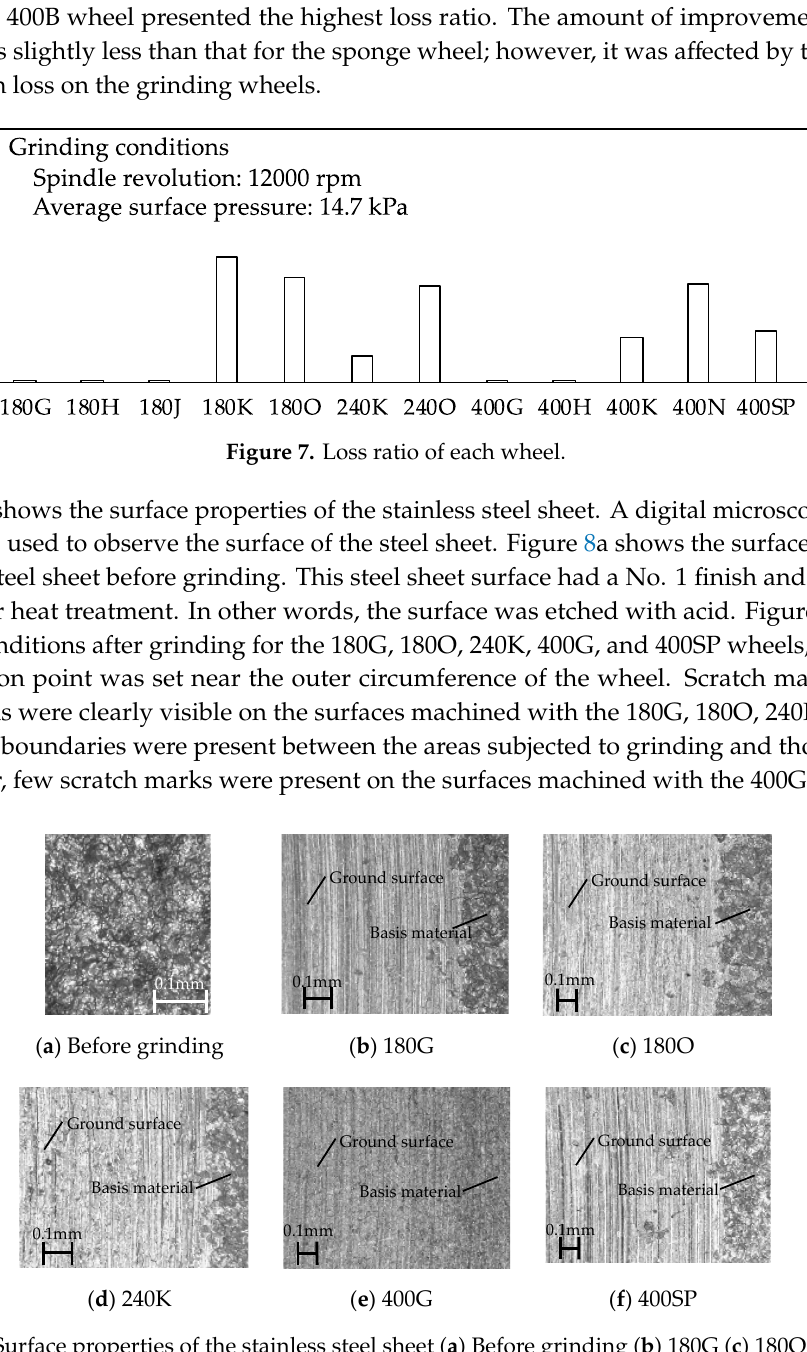
Figure 8. Surface properties of the stainless steel sheet ( a ) Before grinding ( b ) 180G ( c ) 180O ( d ) 240K ( e ) 400G ( f )